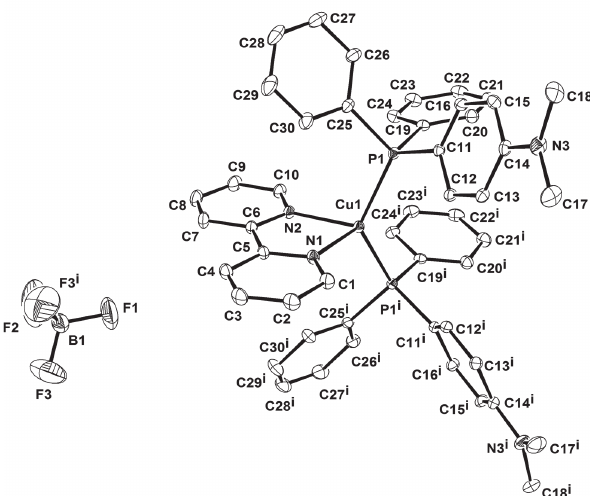
Table 1: Data collection and